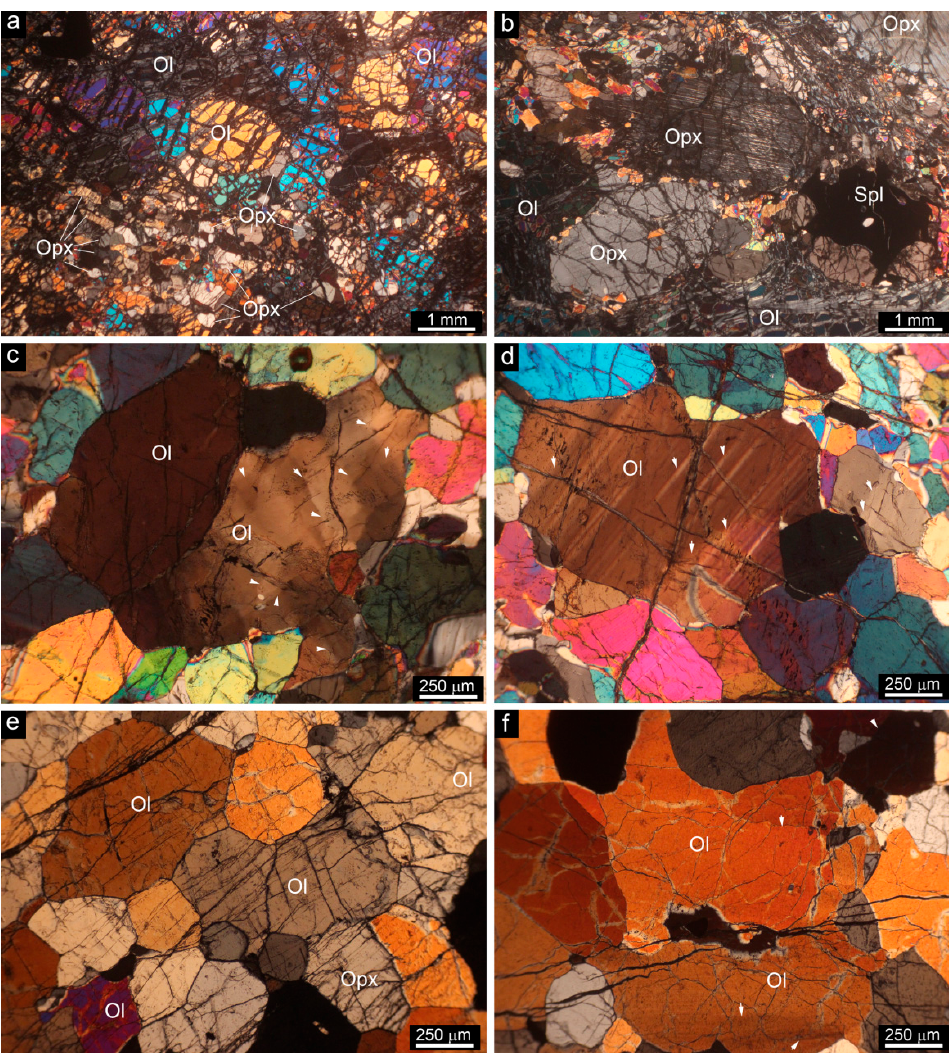
Figure 2. Petrographic features of peridotites from Kempirsay massif: ( a )—Protogranular structure in predominantly olivine aggregate of lherzolite with secondary mesh serpentine (sample 820/300); ( b )—Porphyroclastic structure on the area with predominant enstatite grains in lherzolite (sample 809/347); ( c )—Undulose extinction of olivine grain reflecting a subgrain structure development that induced by plastic deformation (sample 8156); ( d )—Parallel-alternating extinction in plastically deformed olivine grains which surrounded by recrystallized neoblasts in fresh lherzolite (sample 8156); ( e )—Polygonal-grained olivine aggregates (sample 7087); ( f )—Anhedral olivine grain sepa- rated by subgrain boundaries in polygonal-grained aggregate (sample 7087). Arrows note subgrain boundaries. Ol—olivine, Opx—orthopyroxene, Spl—Cr-spinel.